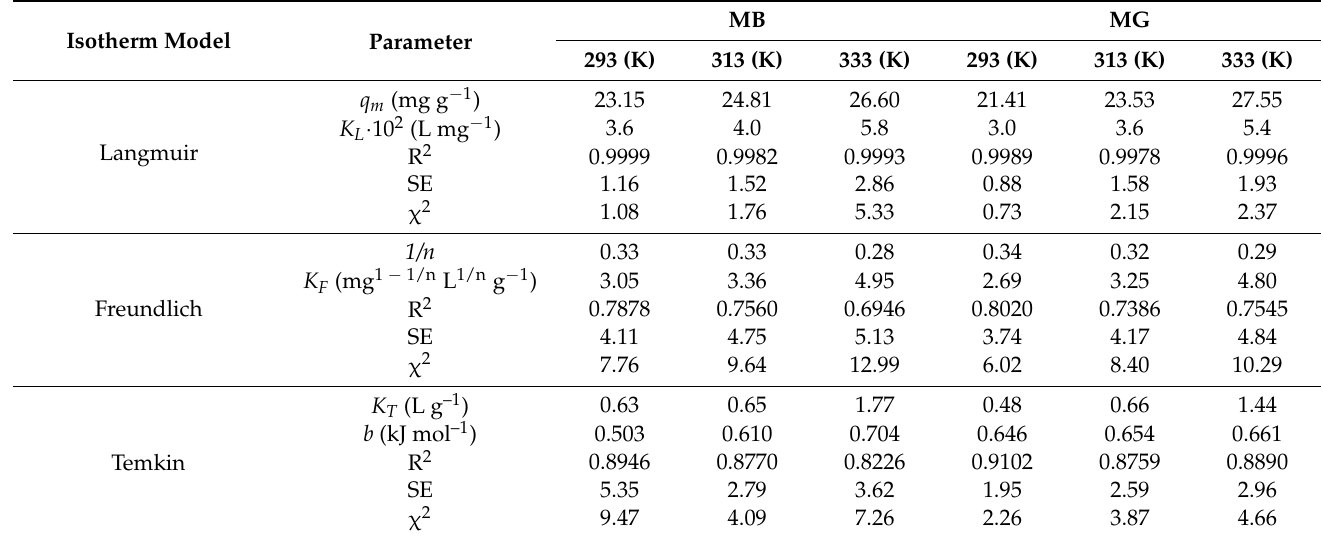
Table 4. Comparison of the isotherm models.